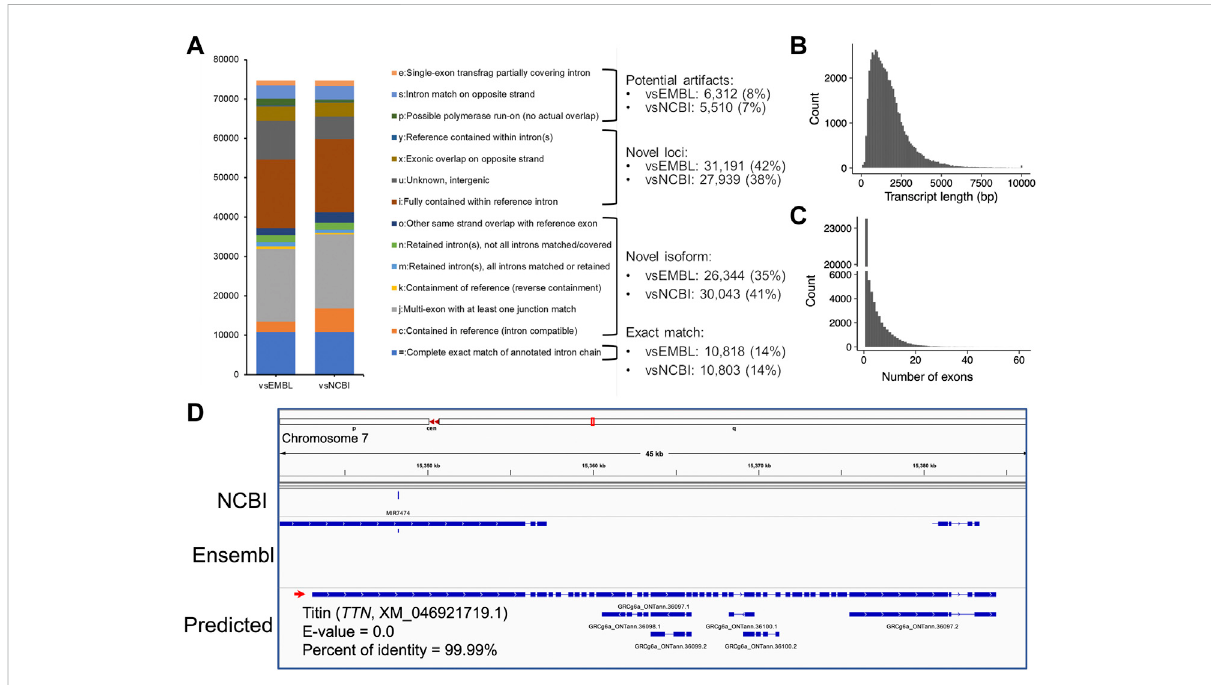
FIGURE 2 Transcript assembly using Nanopore long-read transcriptome data. (A) Comparisons of predicted transcripts against Ensembl (V102, vsEMBL) and NCBI annotation (V105, vsNCBI). The transcripts were classi fi ed according to the GffCompare software (Pertea and Pertea, 2020). The panels (B,C) depict the distributions of predicted transcript length and exon numbers, respectively. (D) A screenshot showing the predicted longest transcript, which is located on chromosome 7 (15,343,033-15,384,347). Blast analysis indicated the transcript matched to the TTN gene locus encoding the titin protein.